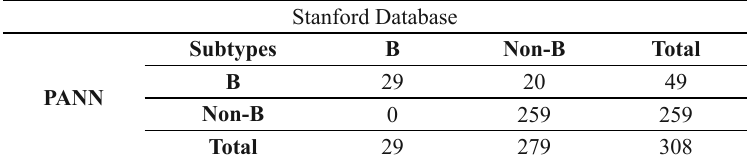
Comparison of B and Non-B subtypes of HIV-1 sequences between Stanford and